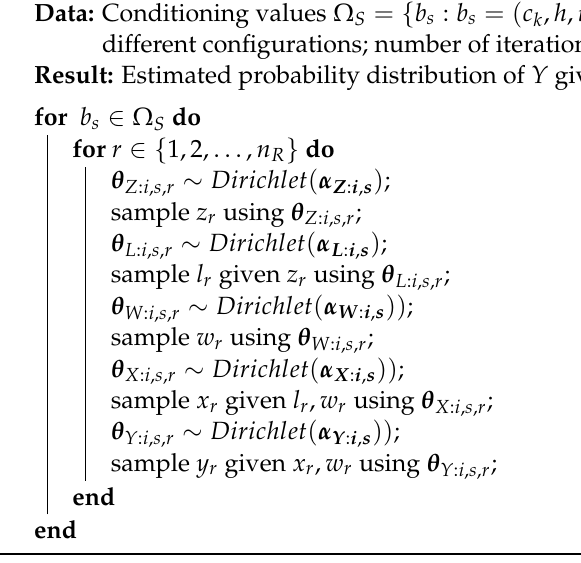
Algorithm 1: Monte Carlo estimate of incidence given information from the current time interval at the end of 3 days after